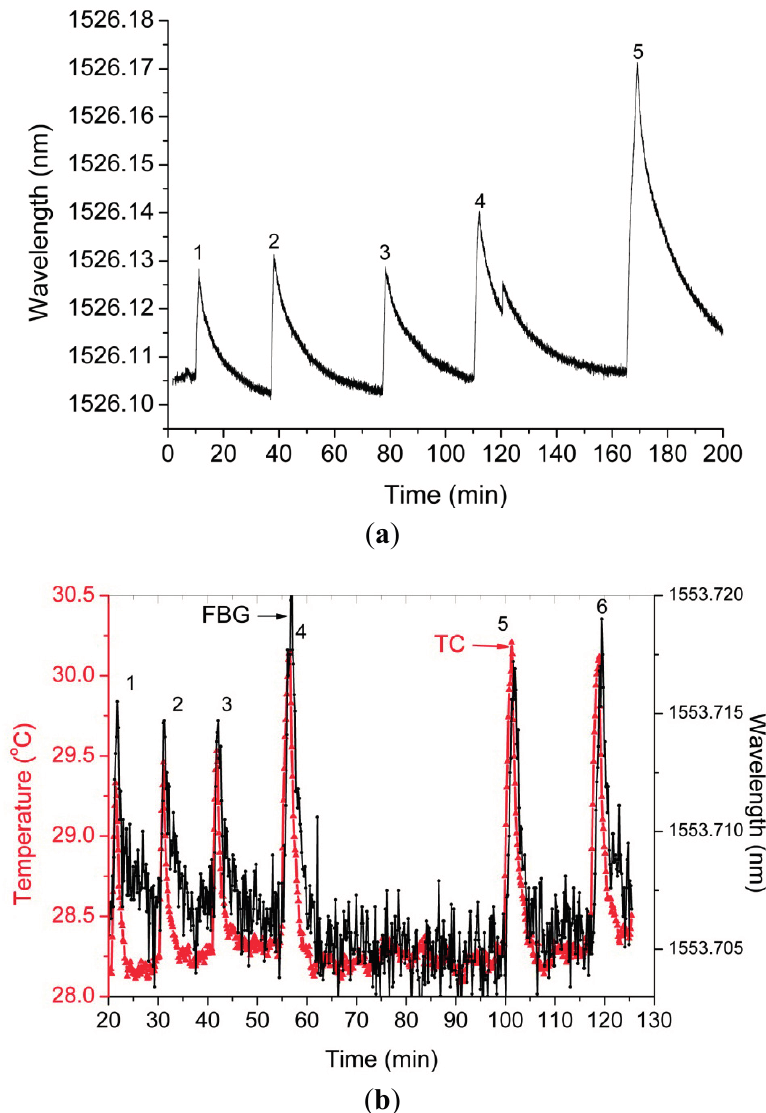
Figure 6. Results of the exposure to the electron beam of: ( a ) a commercially available FBG; ( b ) a FBG (black curve) inscribed into a radiation-hardened optical fiber (RAD HARD FBG). The temperature in the detection plane was monitored by a thermocouple (TC, red